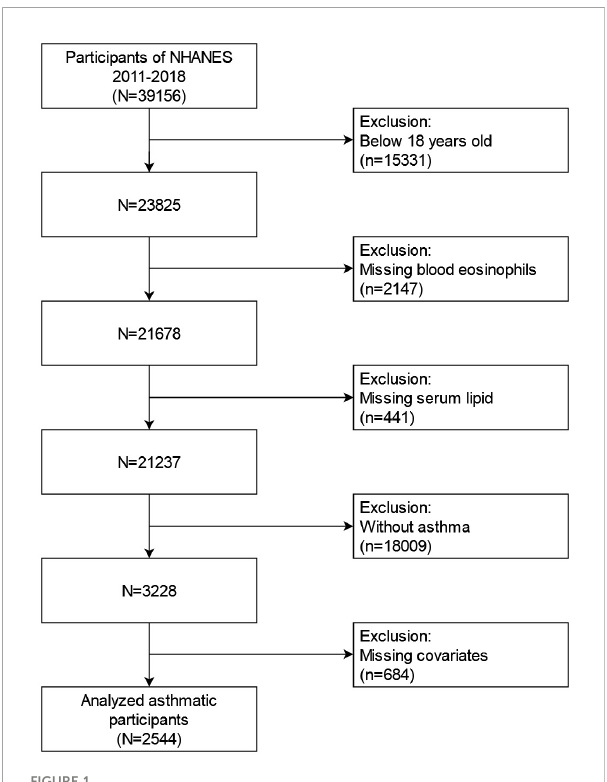
FIGURE 1 Flowchart for choosing participants with asthma for